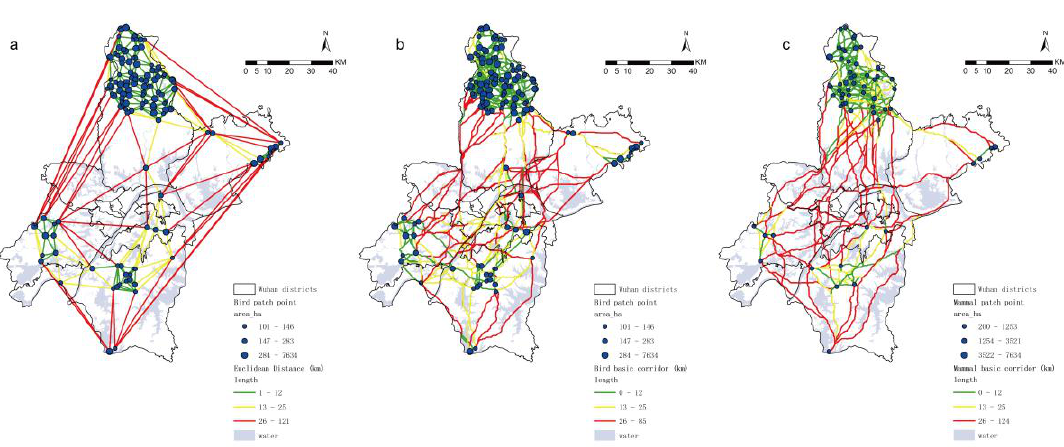
Figure 5. Corridor network comparison. ( a ) The Euclidean distance of birds, ( b ) LCP of birds, ( c ) LCP of small mammals.